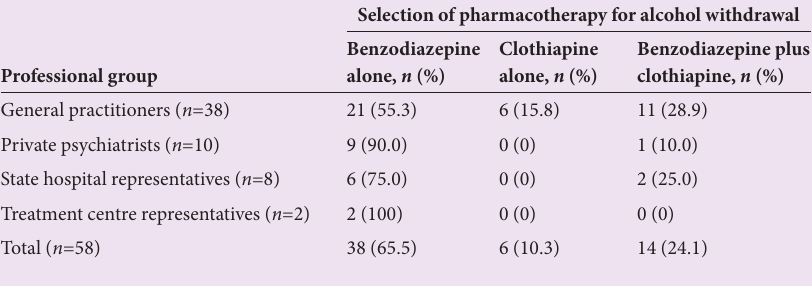
Table 2. Selection of benzodiazepines and/or clothiapine as a substitution agent for alcohol withdrawal by different professional groups